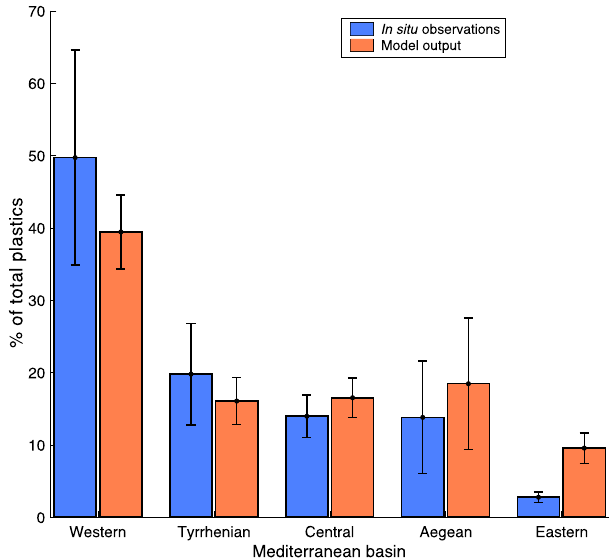
Fig. 2 Plastic in Mediterranean sub-basins. Normalized plastic concentrations across the Mediterranean sub-basins from the Tara Expedition in situ measurements (blue columns) and the model predictions (orange columns), with relative uncertainties (standard deviation: black error bars). In situ plastic concentrations were calculated as the debris weight per unit surface area (g/km 2 ). Model concentrations were calculated as the ensemble average (Scenario M) of the number of virtual particles in a prescribed area around each Tara Expedition station (Methods). R 2 = 0.96, p < 0.01 (Pearson